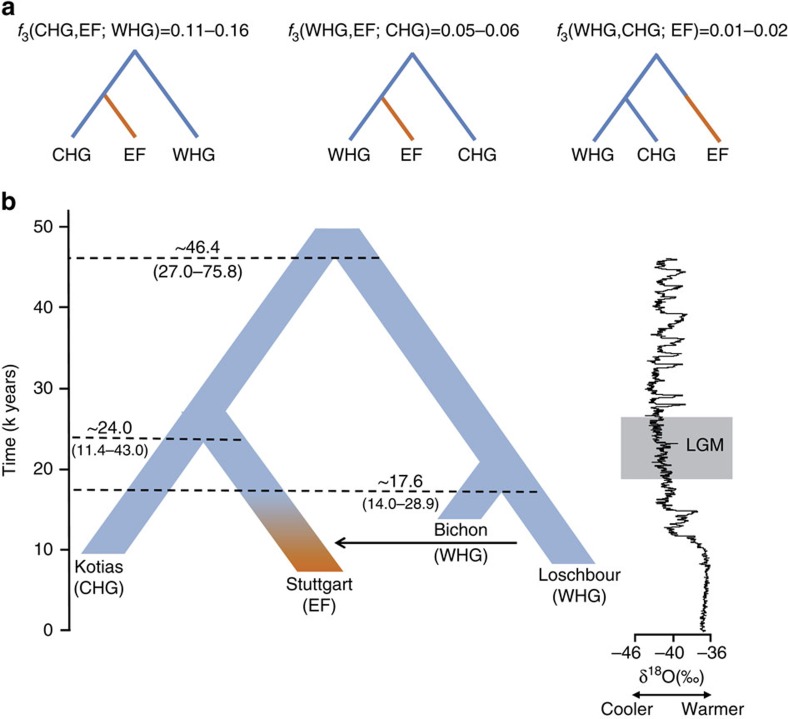
The relationship between Caucasus hunter-gatherers (CHG), western hunter-gatherers and early farmers.(a). Alternative phylogenies relating western hunter-gatherers (WHG), CHG and early farmers (EF, highlighted in orange), with the appropriate outgroup f3-statistics. (b). The best supported relationship among CHG (Kotias), WHG (Bichon, Loschbour), and EF (Stuttgart), with split times estimates using G-Phocs15. Oxygen 18 values (per mile) from the NGRIP core provide the climatic context; the grey box shows the extent of the Last Glacial Maximum (LGM).